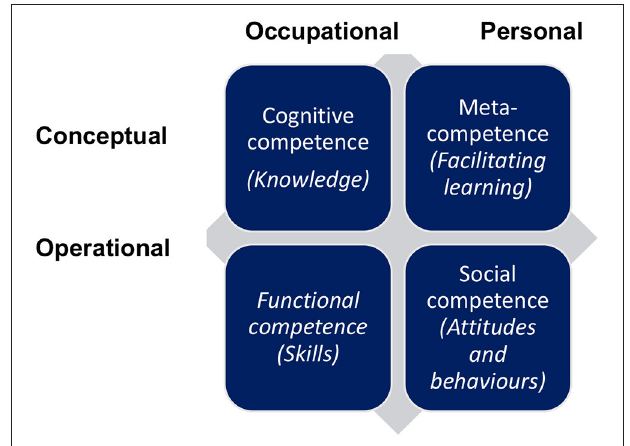
FIGURE 1 | A unified typology of competencies. Source : Adapted from Winterton et al. (2006).